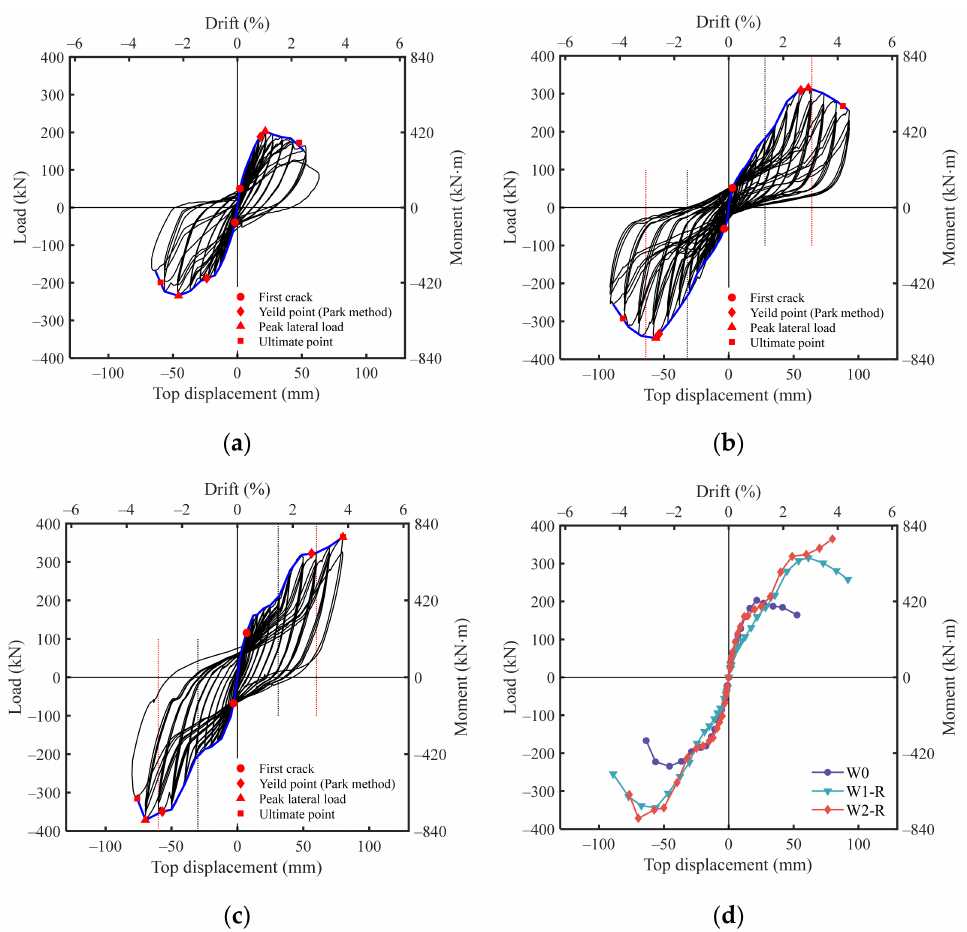
Figure 17. Measured lateral load–top displacement responses (black dotted lines represent VT, red dotted lines represent VC). ( a ) W0; ( b ) W1-R; ( c ) W2-R; ( d ) Comparison of backbone